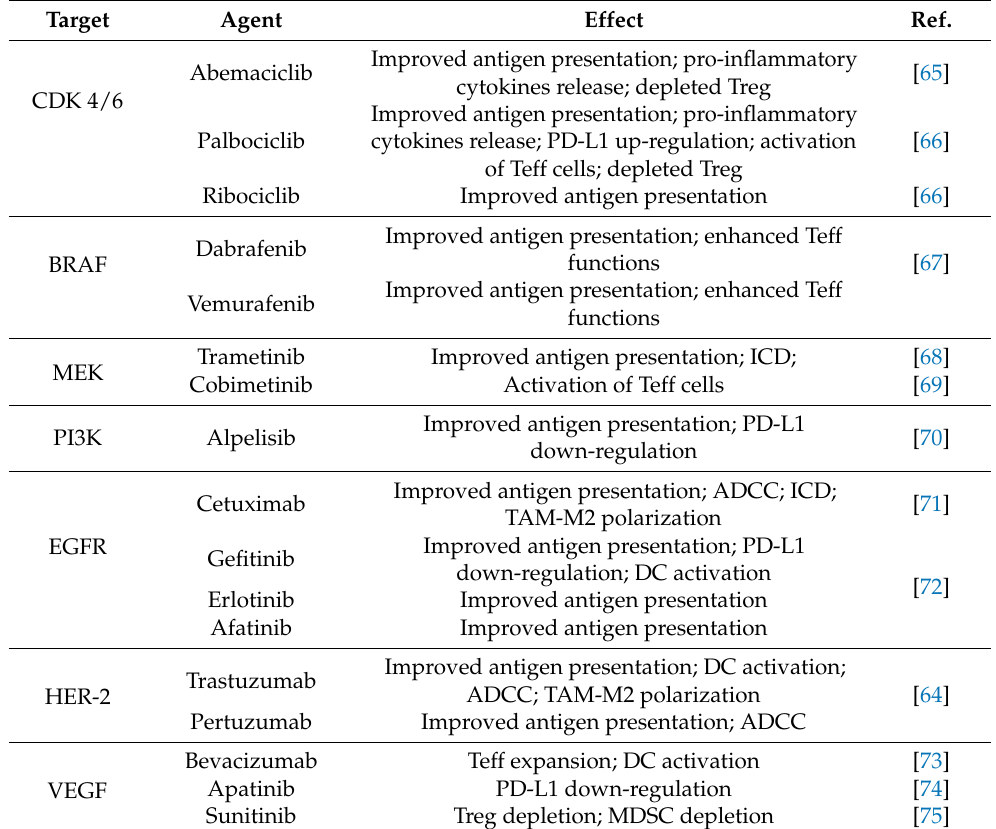
Table 4. Immune effects of selected targeted drugs licensed for clinical